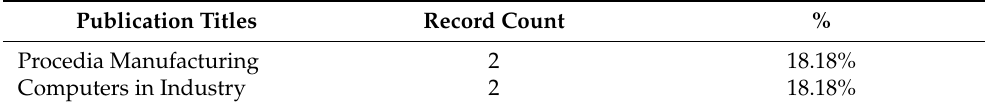
Table 6. Main source titles which contributed to the publication of the scientific articles in scientific journals related to Logistics 4.0 in the SME sector; Source: own study.